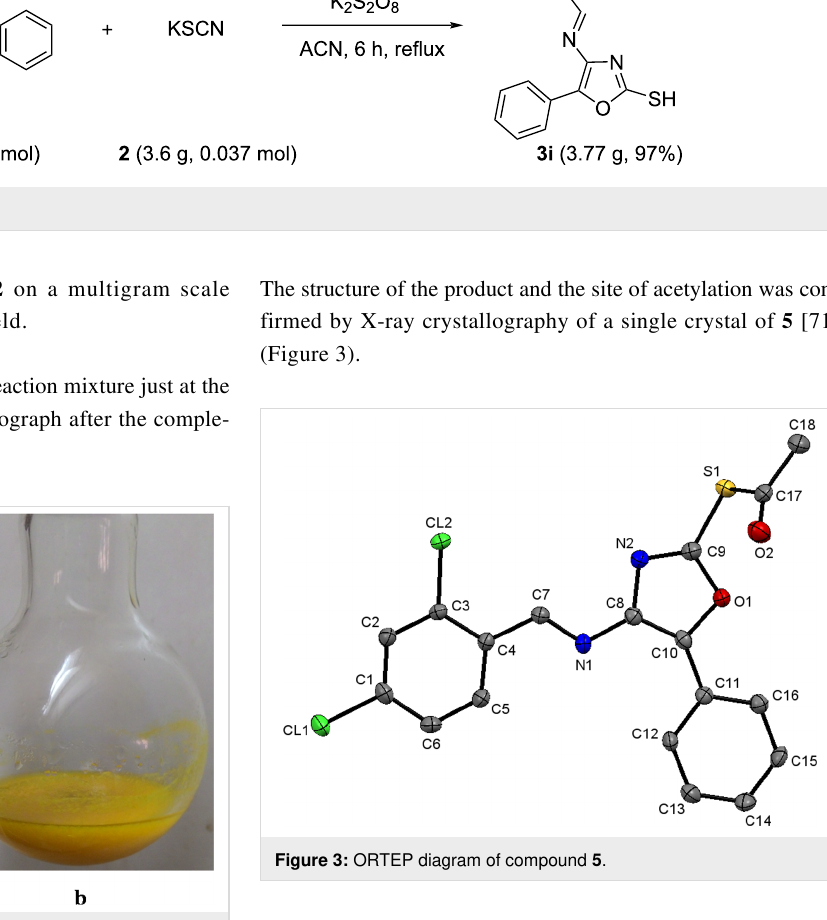
Figure 2: Large-scale synthesis of 3i . a) At the start of the reaction, b) after the reaction.